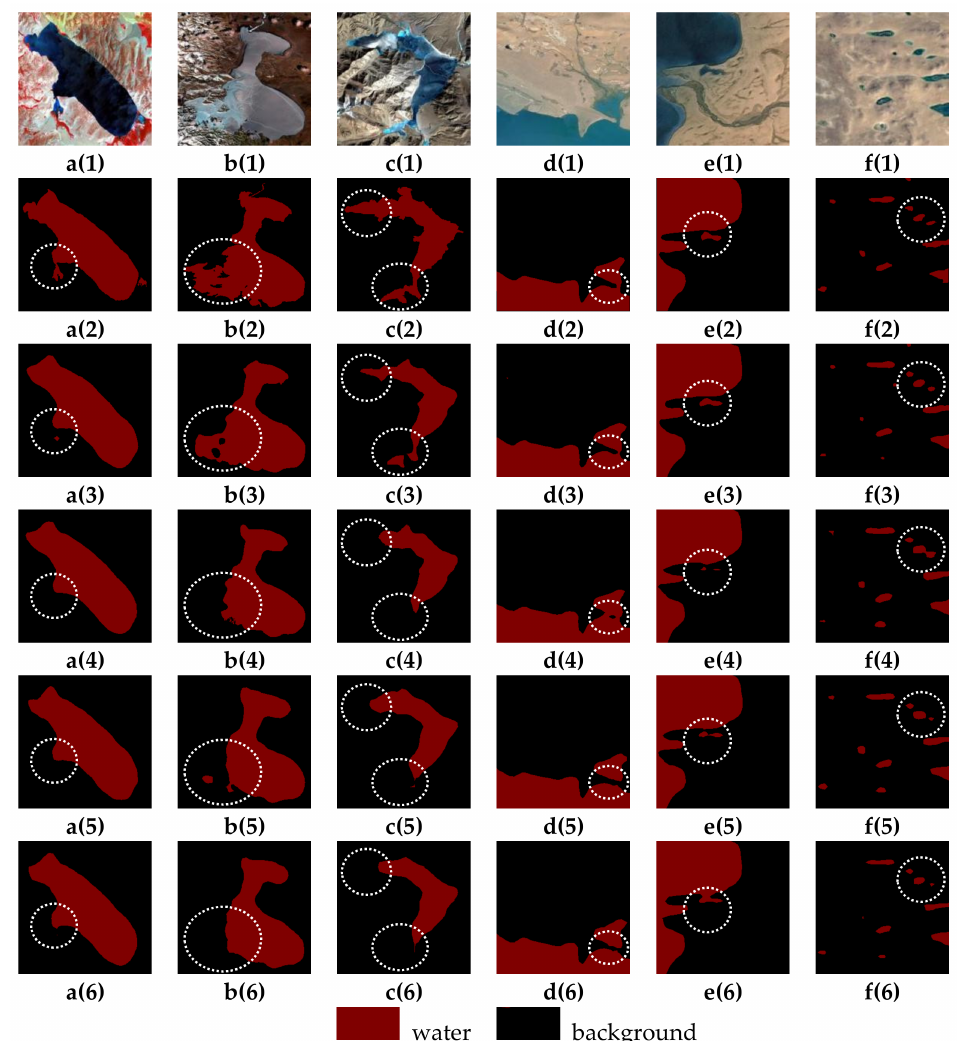
Figure 9. Visualization results of ablation study: a(1) – f(1) , images; a(2) – f(2) , ground truth; a(3) – f(3) , MSNANet; a(4) – f(4) , MSNANet (without FEH); a(5) – f(5) , MSNANet (without OASPP); a(6) – f(6) , MSNANet (without MSNA). a(1) – c(1) —images in the SW dataset; d(1) – f(1) —images in the QTPL dataset. The white circles indicate obvious